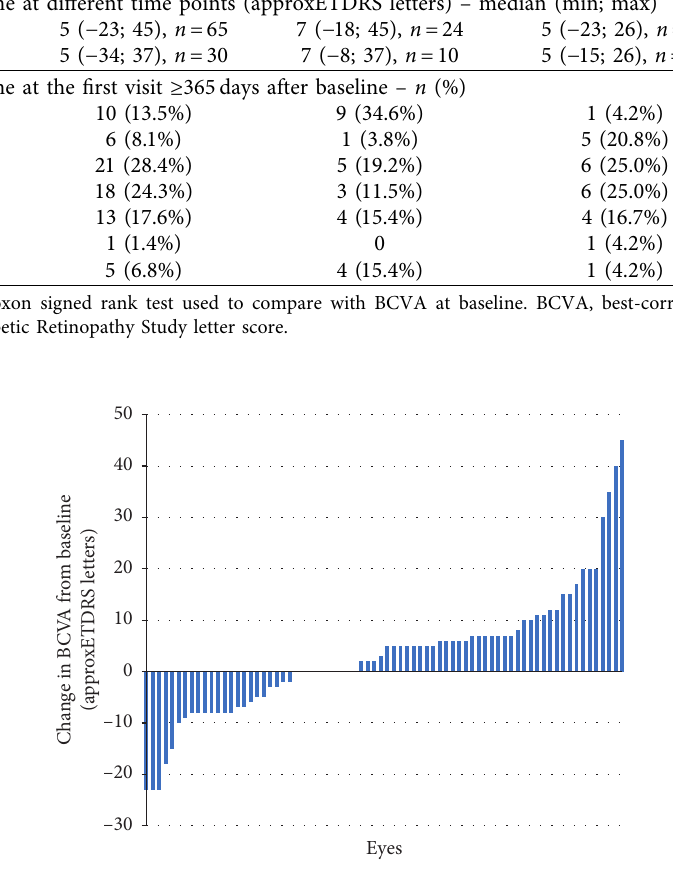
Figure 2: Changes in BCVA from baseline at the first visit ≥ 365 days after baseline. Data from individual eyes ( n �